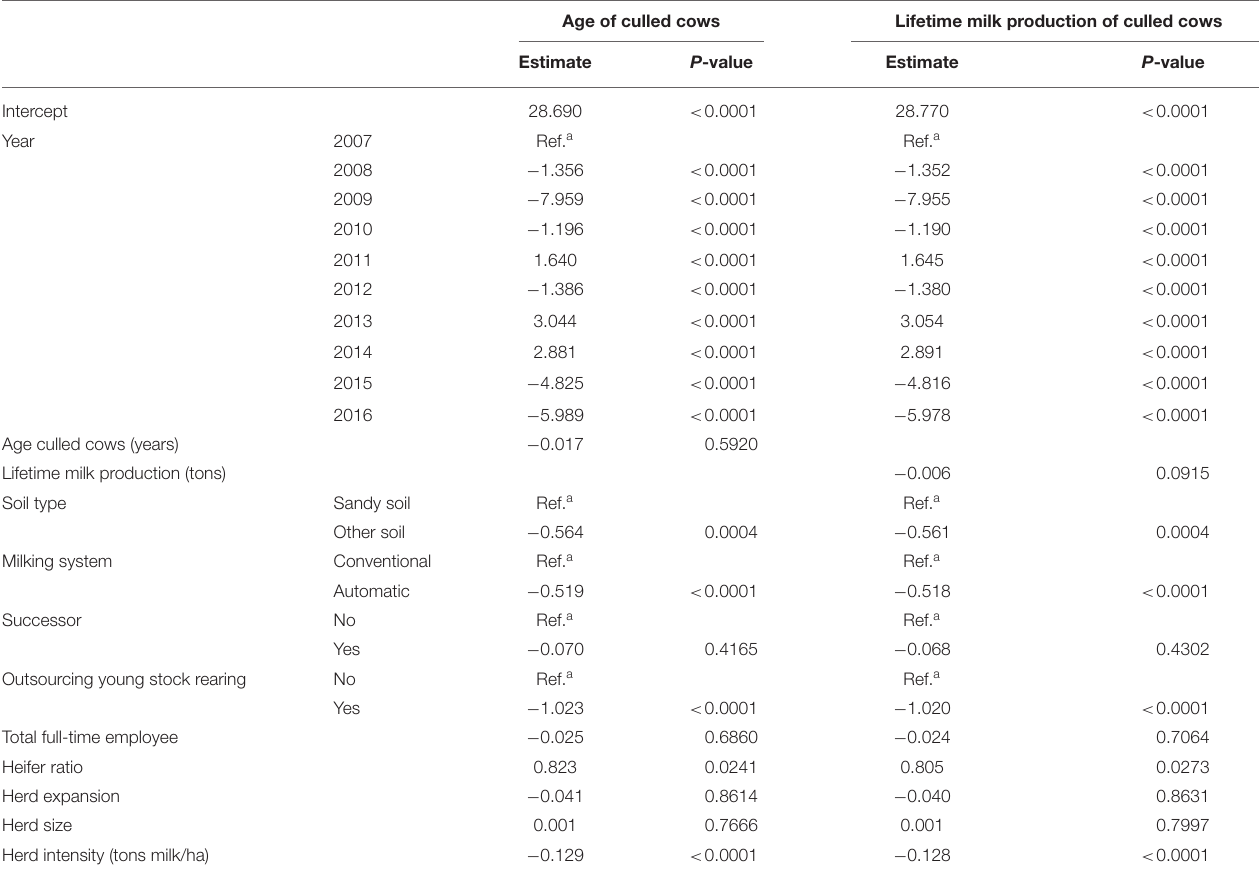
TABLE 4 | Results of the generalized linear mixed models on association between longevity (age of culled cows and lifetime milk production of culled cows) and gross margin (in e /100kg